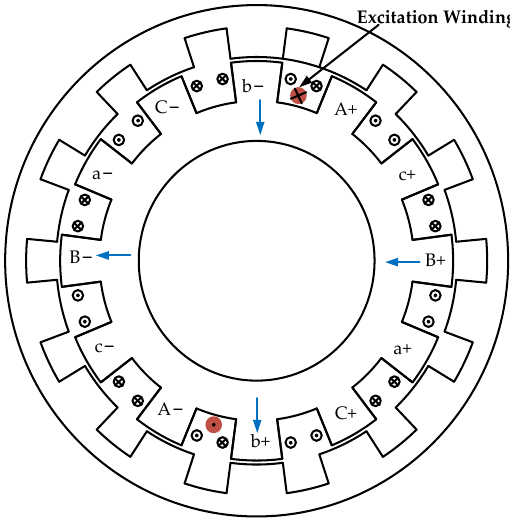
Figure 6. The 12/14 pole outer rotor WEDSM [29].